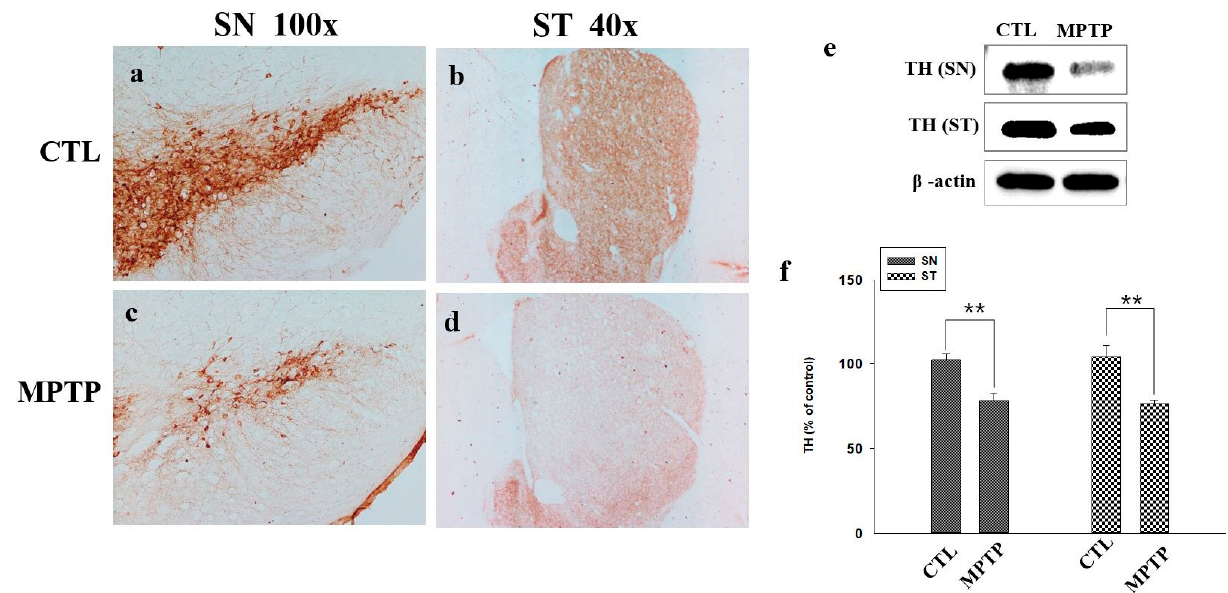
Figure 1. Immunohistochemistry analysis of tyrosine hydroxylase (TH) expression in the substantia nigra (SN; a , c ) and the striatum (ST; b , d ) in the control (CTL) and 1-methyl-4-phenyl-1,2,3,6-tetrahydropyridine-treated (MPTP) groups. TH expression decreased in the ST and SN regions of the brains of MPTP-treated mice. Western blot analyses ( e ) showed that TH expression was significantly decreased in MPTP-treated mice ( f ). ** denotes p < 0.005 compared to CTL. All values are expressed as mean ± standard error, and statistical analysis was performed using Student’s t